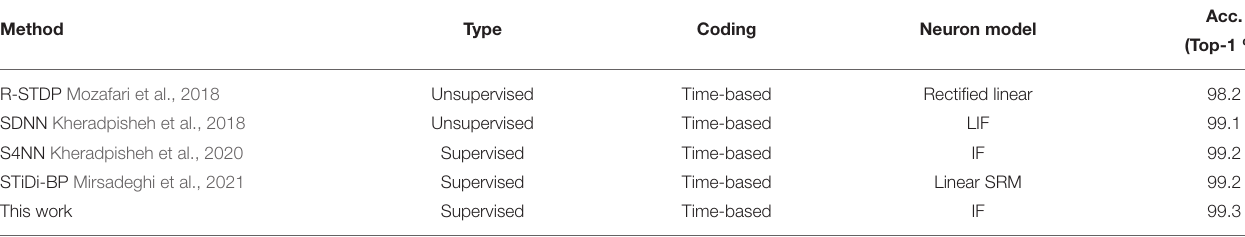
TABLE 1 | Test accuracy of SNNs trained with different learning methods on Caltech face/motorcycle dataset.